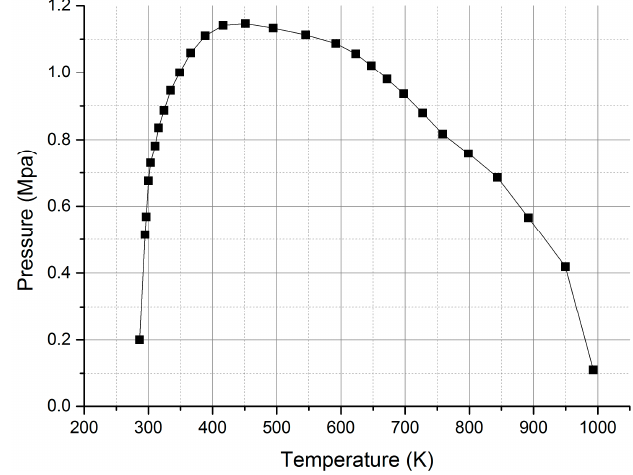
Figure 7. Relationship between temperature and pore pressure of carbon/phenolic composites.